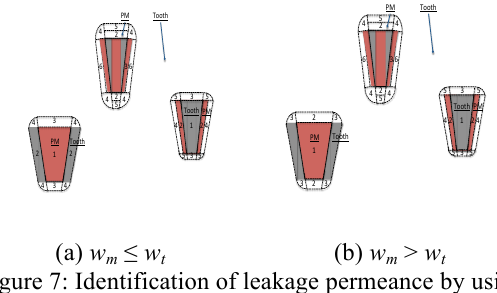
Figure 7: Identification of leakage permeance by using the assumptive magnetic flux path method.